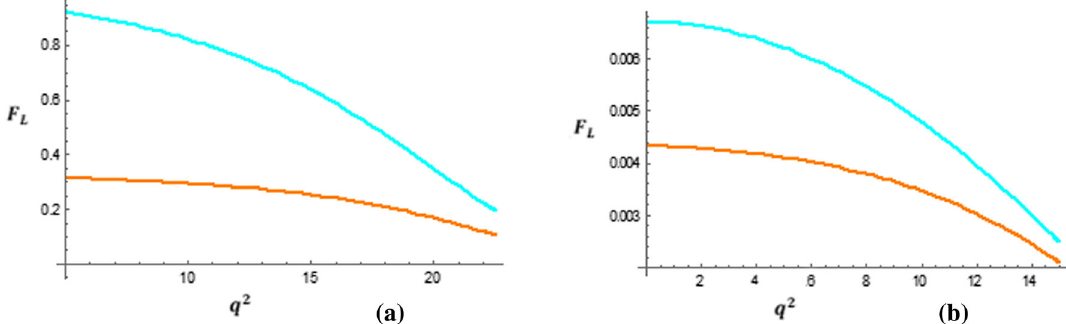
Fig. 5 Variation of longitudinal polarization fraction for a B → K ∗ μ − τ + , b B → K ∗ e − μ +